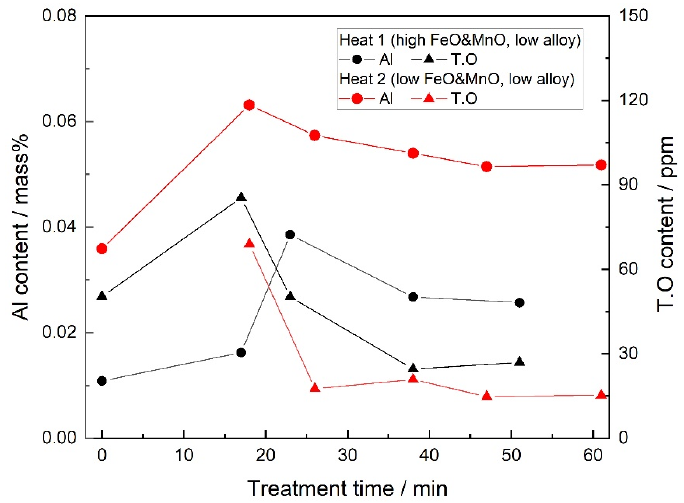
Figure 6. Comparison on the Al and total oxygen contents between heat 1 and heat 2. differences in the Al contents, the Mg content of heat 2 was higher than heat 1. For both from the top slag or refractory by the dissolved Al in molten steel, and a higher Al content led to a higher Mg content. However, the Ca contents were low and similar for both heats, despite the differences in the Al contents. This indicated that the reduction rate of CaO from the top slag by dissolved Al in molten steel was extremely slow.